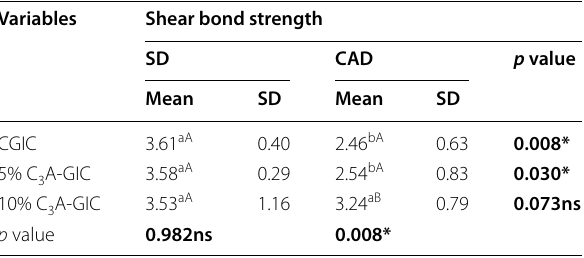
Table 4 The mean, standard deviation (SD) values of Shear bond strength of different groups Variables